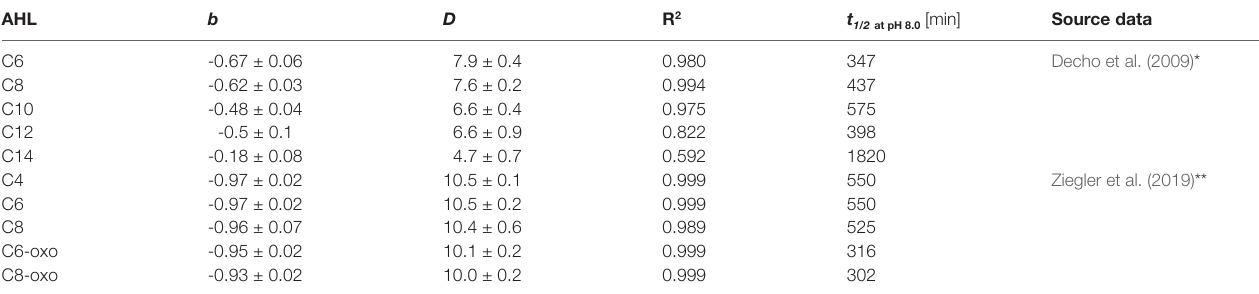
TABLE 2 | Coefficients (± SD) of the relationship between half-life time t 1/2 and pH expressed as linear equation of the form log( t 1/2 ) = b x pH + D, valid for the pH range from 6.0 to 10.0. AHL b D R 2